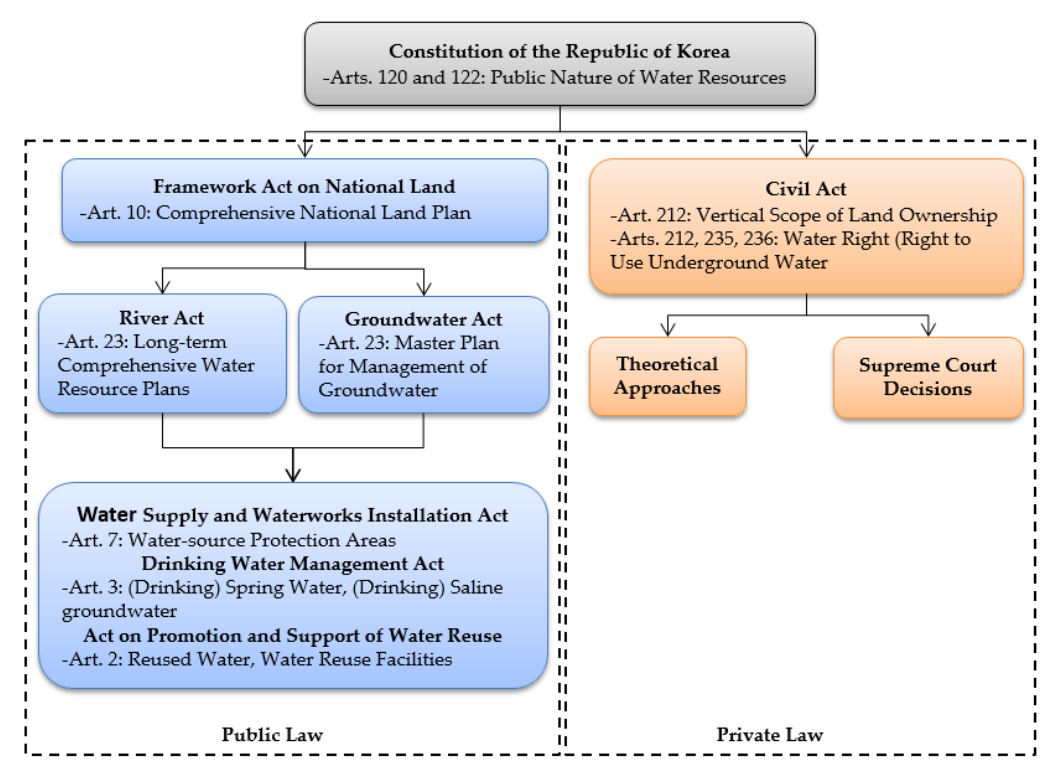
Figure 4. Overview of the existing legal and policy system concerning ASWQE projects in Korea.